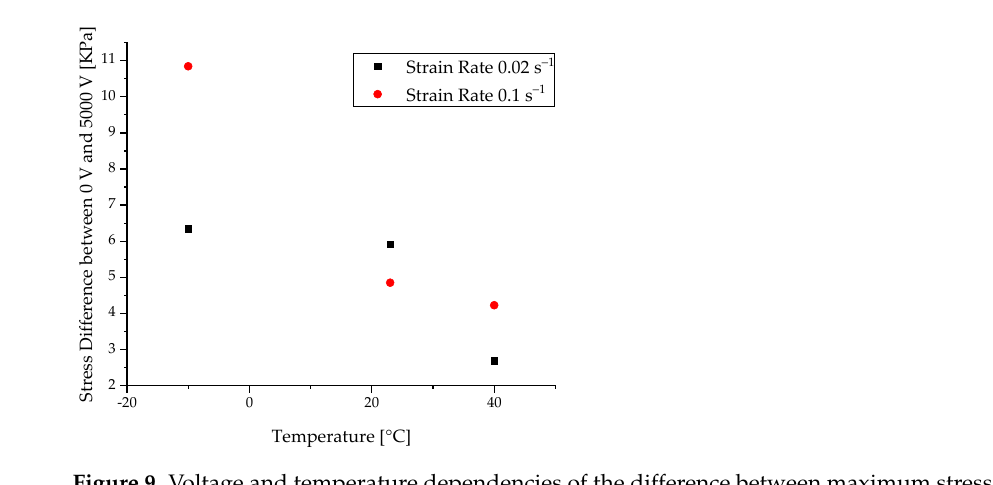
Figure 8. Voltage and temperature dependencies of the maximum stress values during the hystere- sis for ( a ) strain rate 0.02 s − 1 and ( b ) 0.1 s − 1.